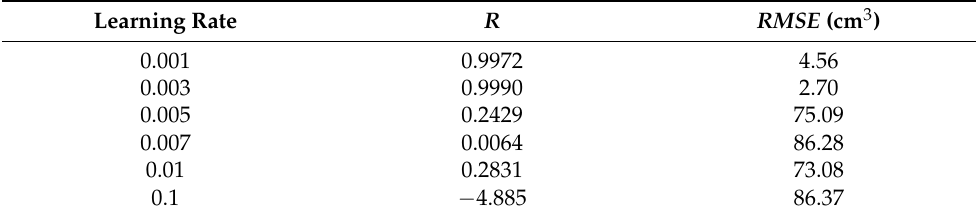
Table 2. The effect of learning rate on the model.